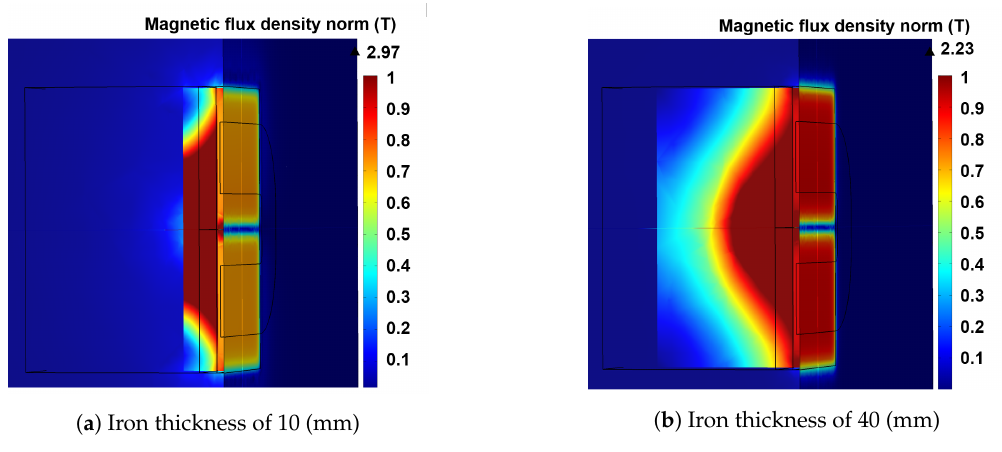
Figure 11. Magnetic field amplitude (T) for different iron pieces thicknesses, 3D